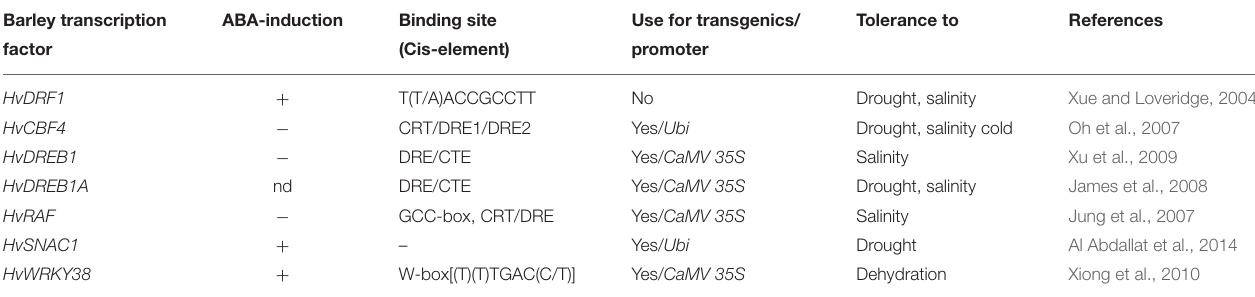
TABLE 1 | Features of stress-related transcription factors (TFs) cloned and characterized from barley and their use in transgenic